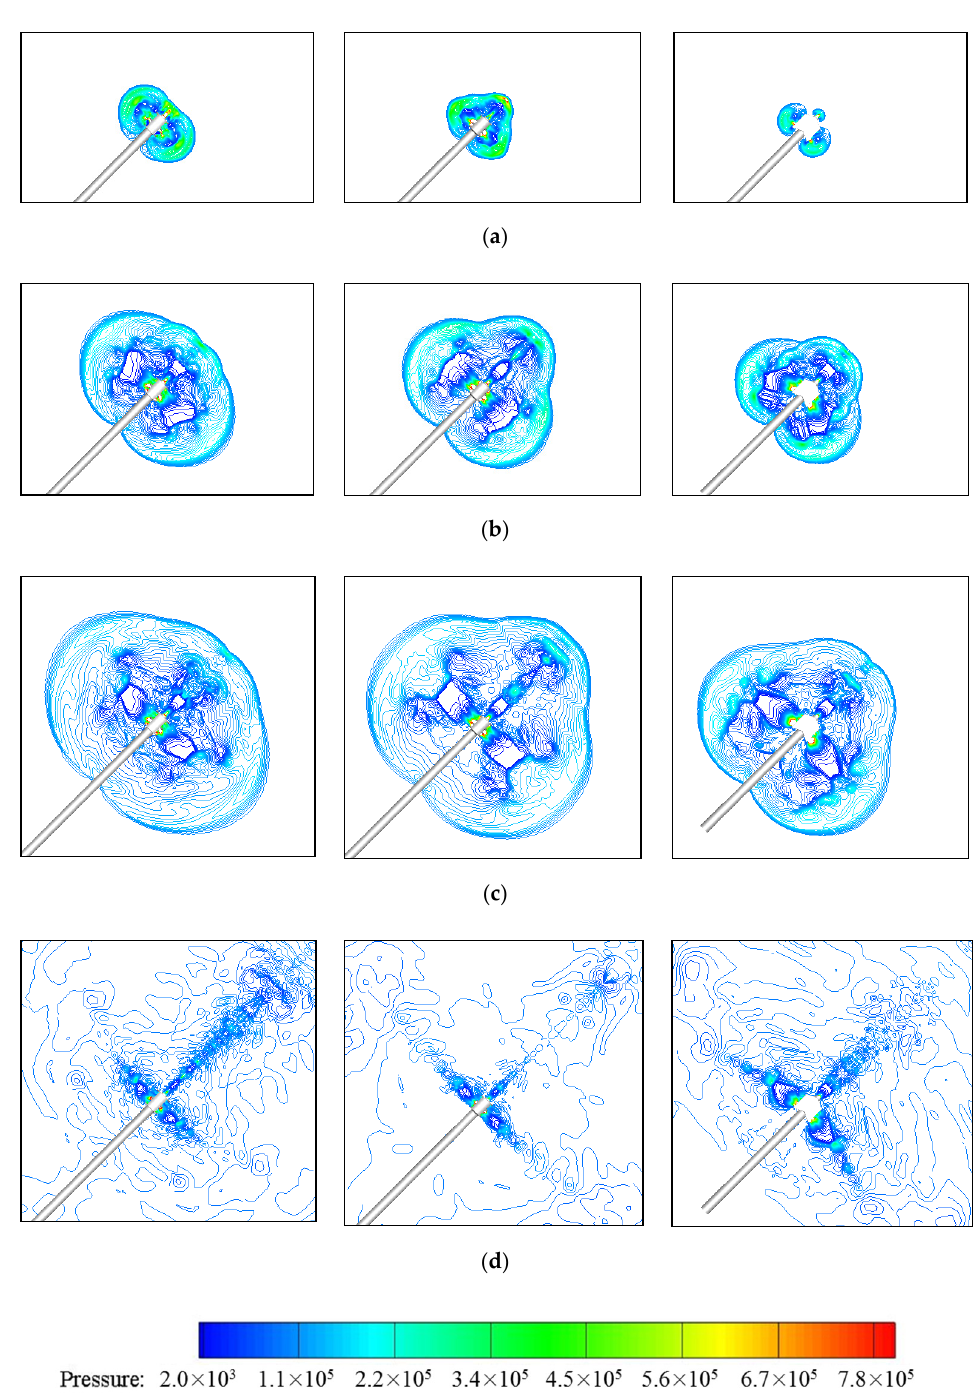
Figure 20. Pressure contour distribution of three different muzzle brake. ( a ) t = 0.25 ms. ( b ) t = 0.50 ms. ( c ) t = 0.75 ms. ( d ) t = 2.50 ms. (from left to right the muzzle brakes were defined previously as one to three types).